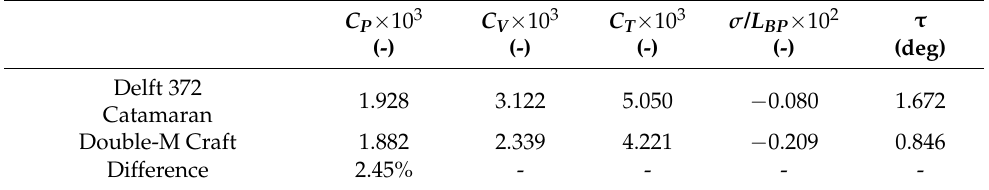
Table 7. Resistance components of Delft 372 catamaran and Double-M craft for Fr = 0.7.